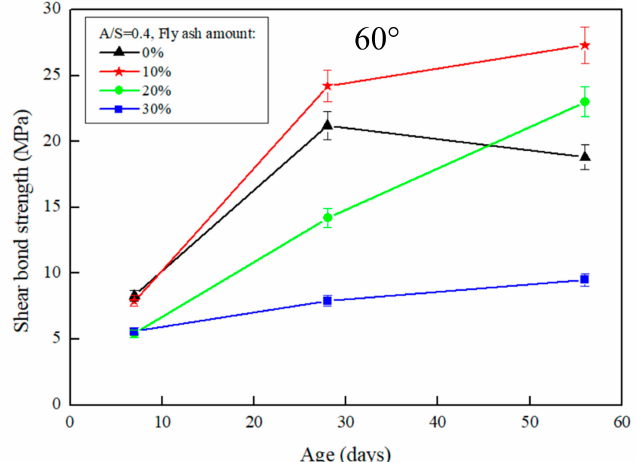
Figure 5. The e ff ect of di ff erent fly-ash amount on the slant shear test of FGG when L / S = 0.4 and repair angle was 60 ◦ .